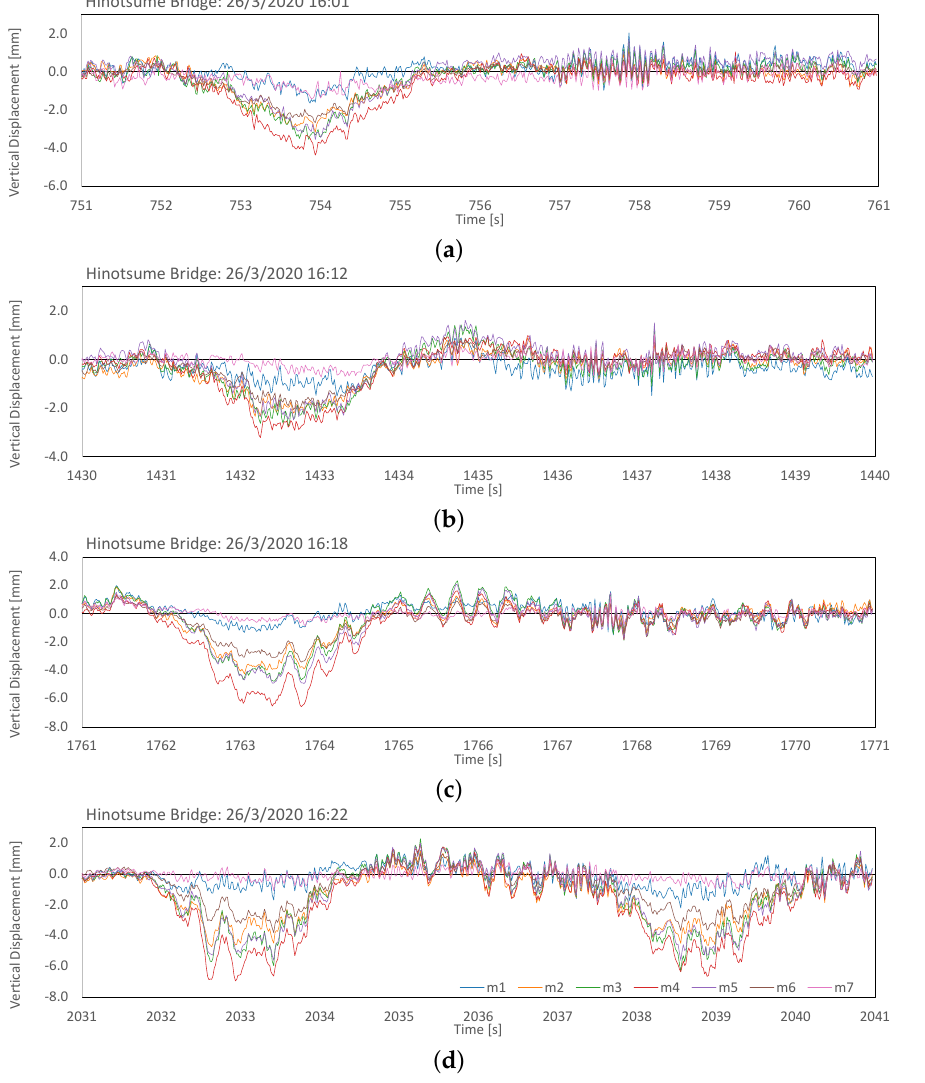
Figure 15. Ten-second segment of marker displacement upon large vehicles passes at 16:01 ( a ), 16:12 ( b ), 16:18 ( c ), and 16:22 ( d ). A notable first-mode vibration component (0.3 Hz) was observed on the markers for the duration of approximately 3 s upon excitation from the pass of a large vehicle, followed by high-frequency small-amplitude transient damped vibration. Consecutive pass(es) of either large ( d ) or small ( c ) vehicles following an initial excitation from a large vehicle’s pass resulted in a sustained, 3-Hz